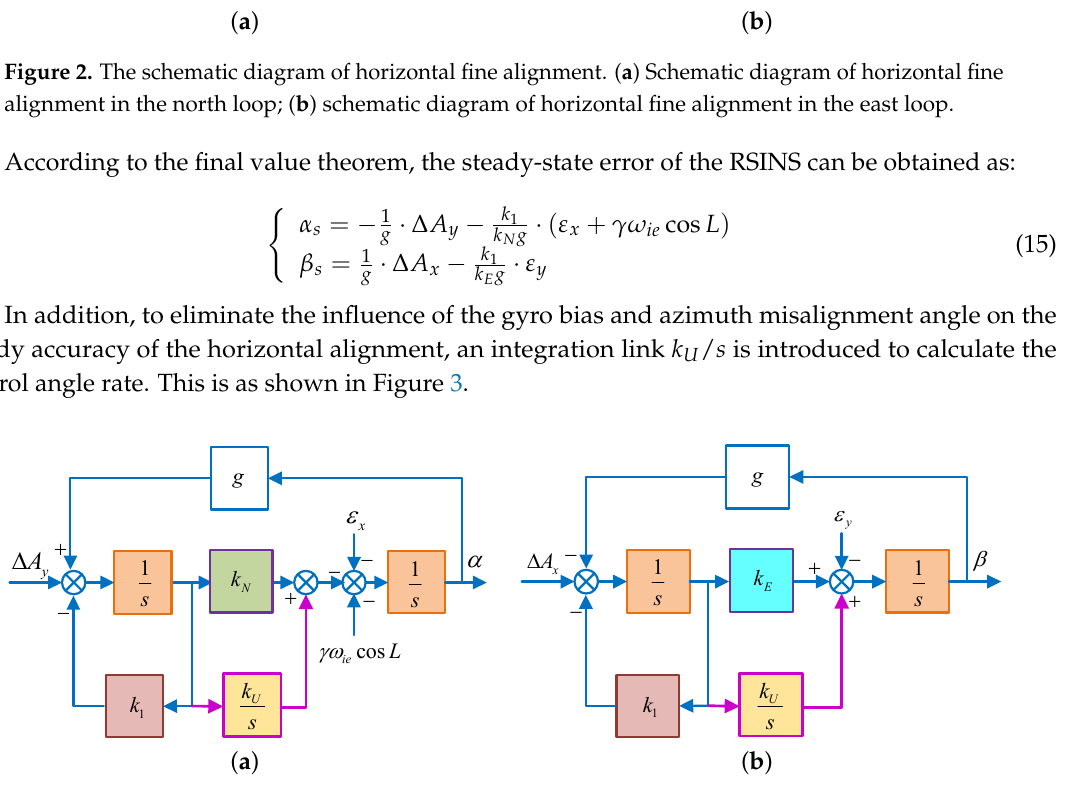
Figure 3. The schematic diagram of horizontal fine alignment. ( a ) Schematic diagram of horizontal fine alignment in the north loop; ( b ) schematic diagram of horizontal fine alignment in the east